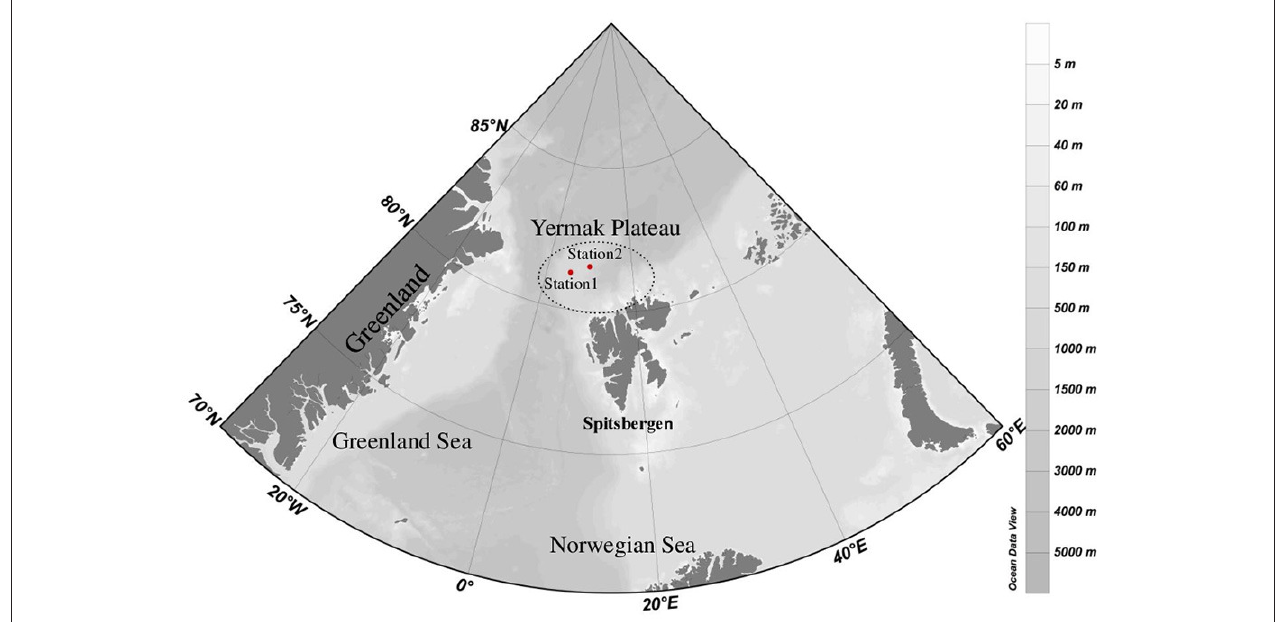
FIGURE 1 | Map of the studied area showing the locations of the two sampling stations (Station 1, Station 2) NW of Spitsbergen.